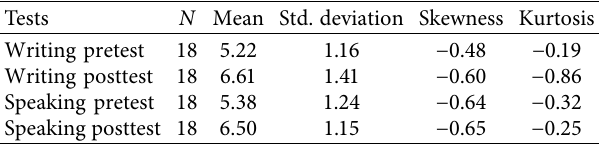
Table 3: Descriptive statistics comparing the pretest and posttest scores of the HPBL